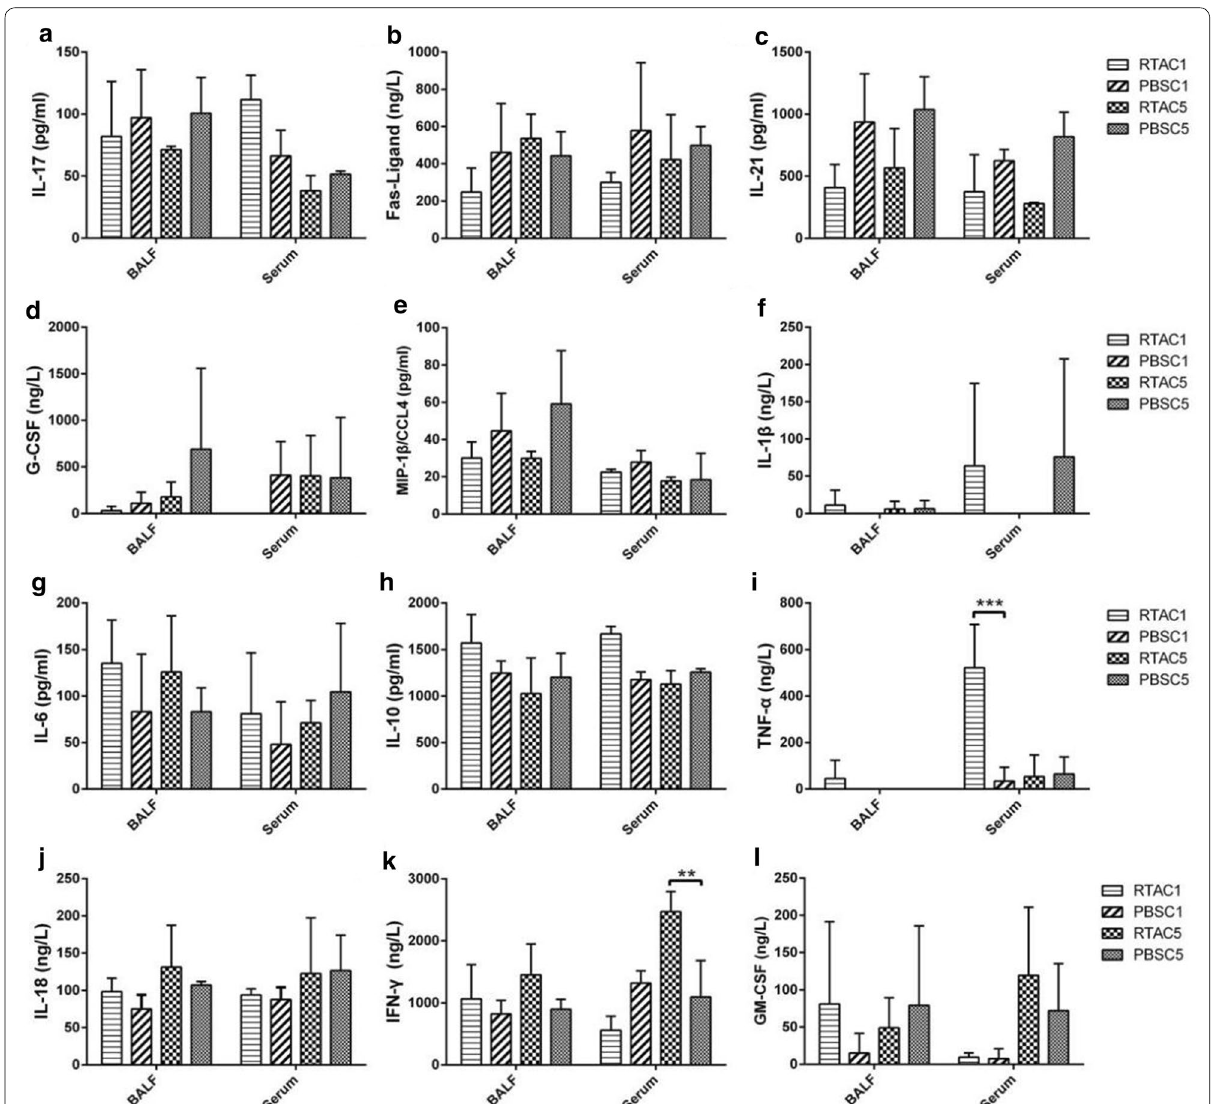
Fig. 5 Detection of the cytokine level in the BALF and the serum of mice at 72 h after challenge. The changes in the expression levels of cytokines in the BALF and serum of each group were detected by indirect ELISA, namely, the changes in IL-17 ( a ), Fas-ligand ( b ), IL-21 ( c ), G-CSF ( d ), MIP-1β/ CCL4 ( e ), IL-1β ( f ), IL-6 ( g ), IL-10 ( h ), TNF-α ( i ), IL-18 ( j ), IFN-γ ( k ) and GM-CSF ( l ) levels. *, P < 0.05; **/***, P <